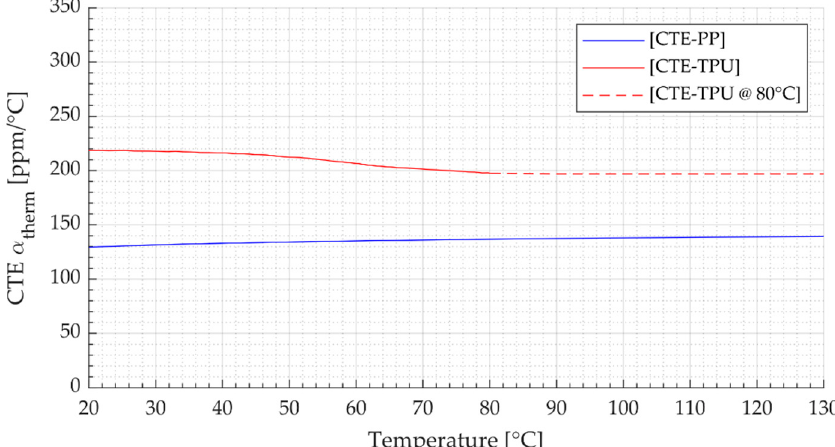
Figure 2. CTE for TPU according to manufacturer’s specifications within the range 20 °C to 80 °C (CTE-TPU, red line), retained value of CTE of TPU at 80 °C for the remaining temperature range (CTE-TPU @ 80 °C, red dashed line), and experimentally determined CTE of PP (CTE-PP, blue line).